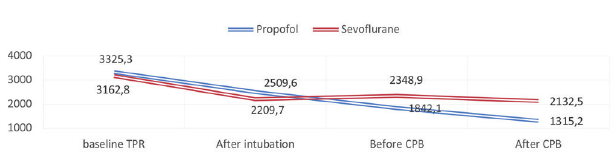
Figure 4 - Total peripheral vascular resistance before and during anaesthesia.